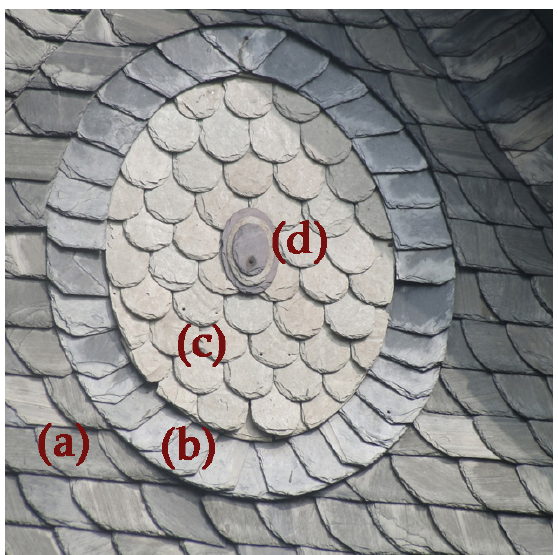
Figure 4. Opencast slate mining in Spain (Valdeorras, Luarca slate).